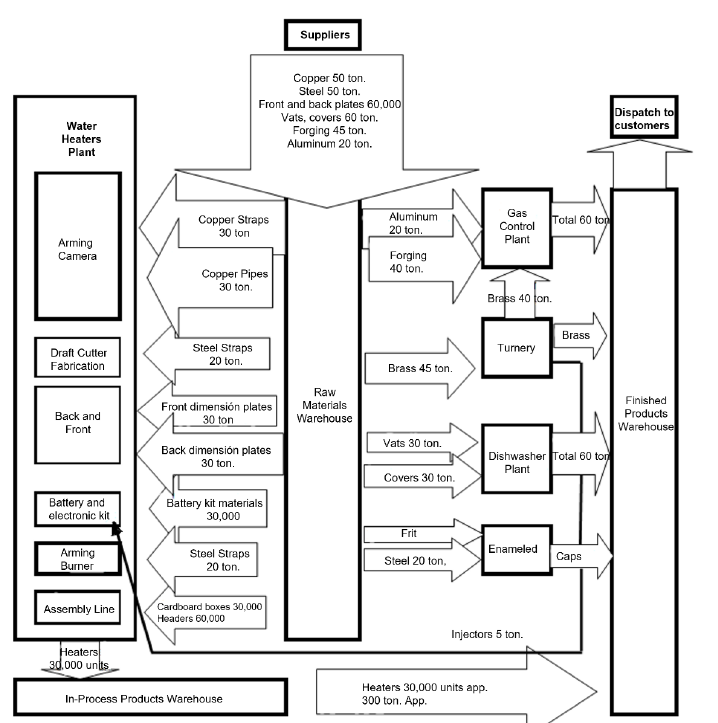
Figure 4. Valued flowchart of the